Question: Write a caption explaining this figure to a reader.
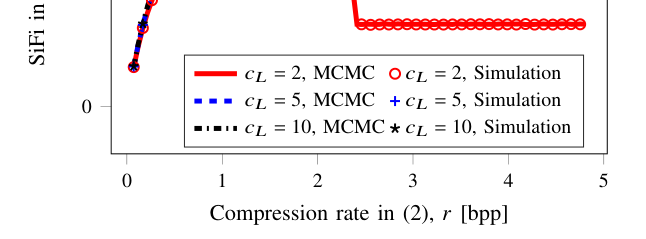
Answer: SiFi in (13) against the compression rate 𝑟in [bpp]. ‘MCMC’ refers to the approximation of the expected SiFi in (20), while ‘Sim- ulation’ refers to the one obtained by averaging (13). The number of available transmission slots 𝐿is calculated as 𝐿= 𝑐𝐿⌈𝑟max/𝑟⌉, where 𝑟max = 4.86 is the average bpp for the PNG compressed images and 𝑐𝐿is a coefficient value [10].